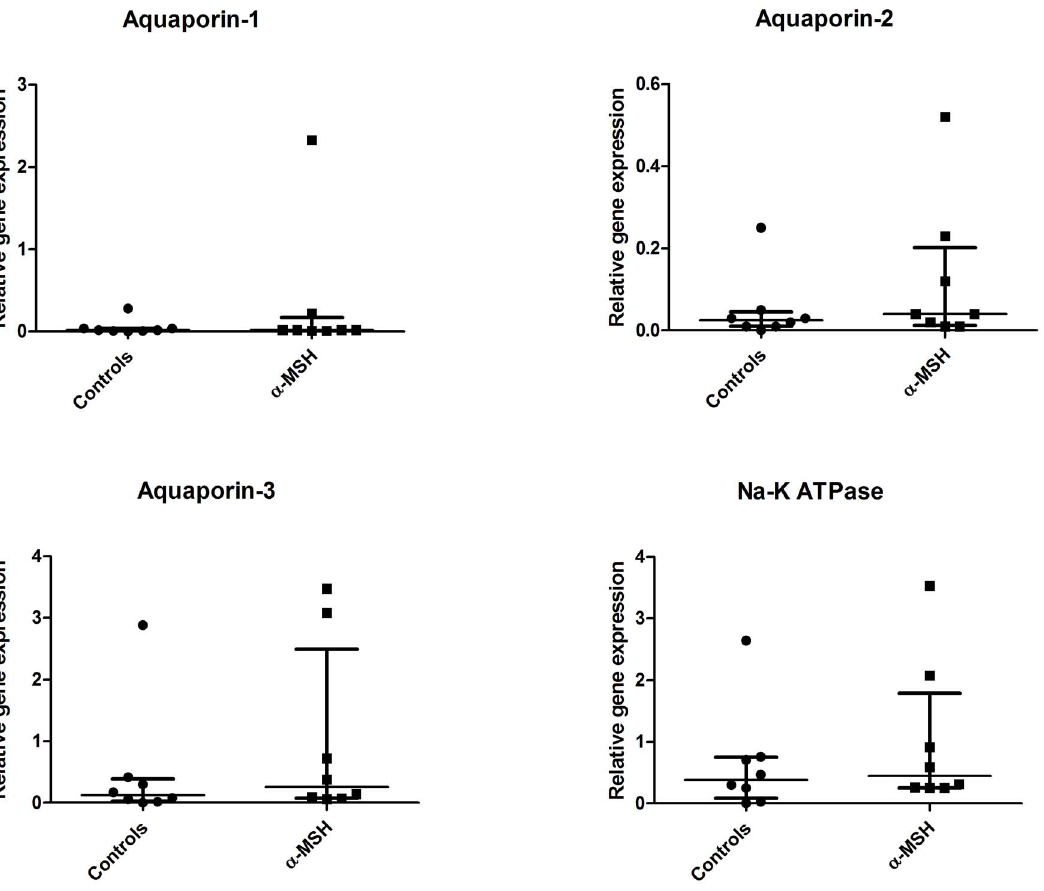
Figure 10. The effect of a -MSH on aquaporins and Na-K ATPase. No significant differences were observed in mRNA expression of aquaporines or Na-K ATPase mRNA expression between controls and a -MSH treated animals at ten hours post-reperfusion.